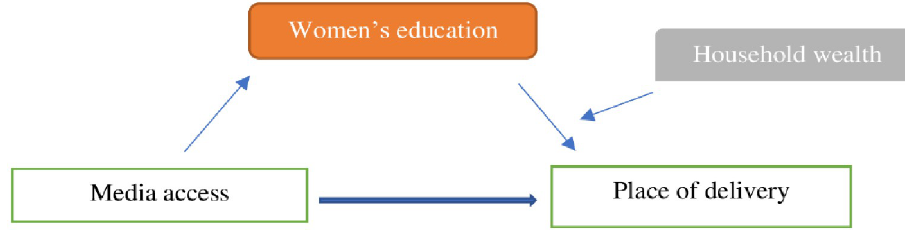
Fig 1. Moderated mediation